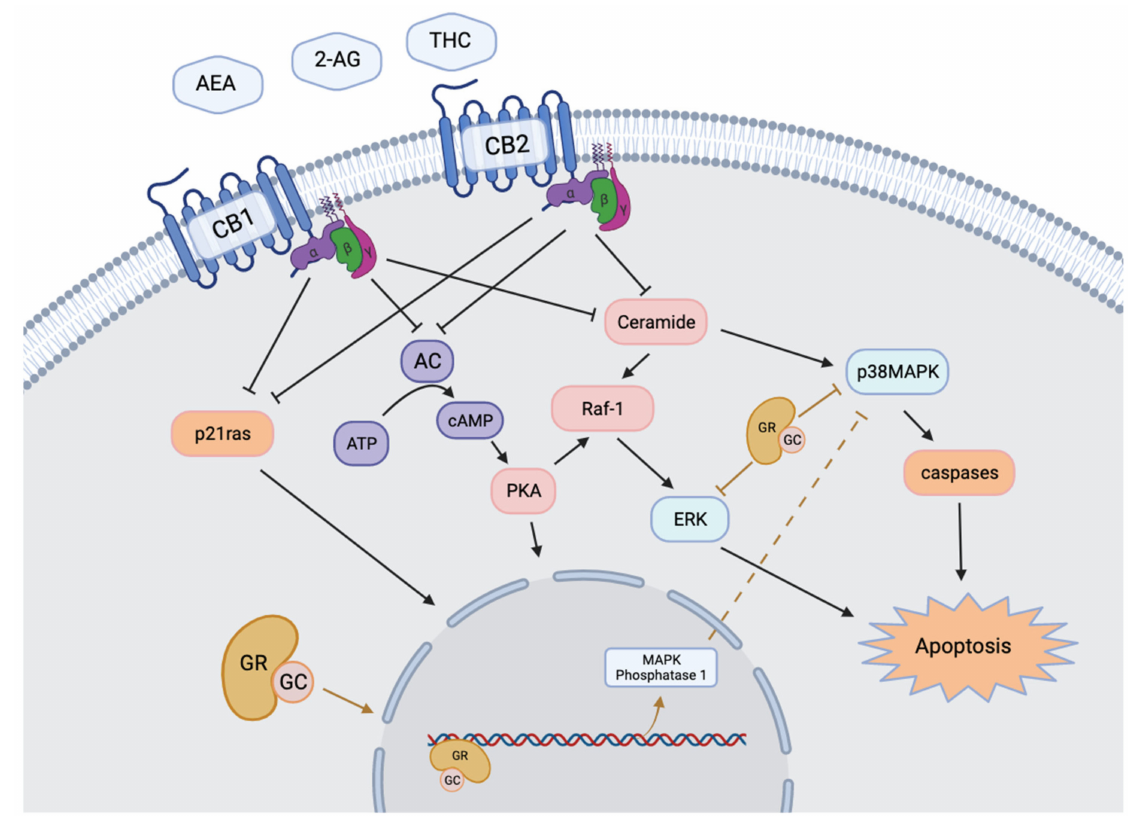
Figure 1. Intracellular regulatory mechanisms stimulated by endocannabinoid and glucocorticoid receptors. Activation of transmembrane cannabinoid receptors CB1 and CB2 stimulates intracellular production of ceramides and inhibition of adenylyl cyclase and p21ras. Activation of membrane bound or cytoplasmic GR results in the cleavage of the peptide into a transcription factor. The two systems converge on transcriptional regulation and modulation of MAPK signaling pathways. Modified from Misner, 2020